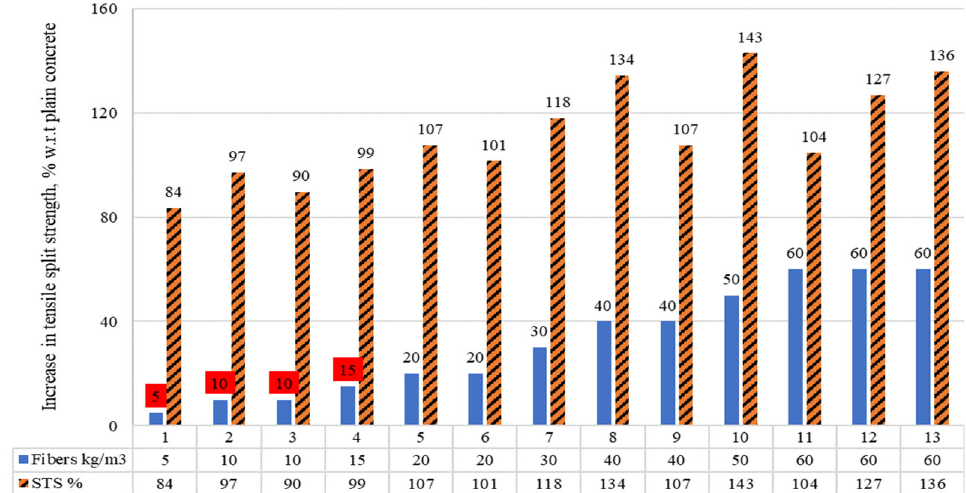
Figure 11. Percentage comparison of split tensile strengths of concrete containing RSF in kg/m 3.